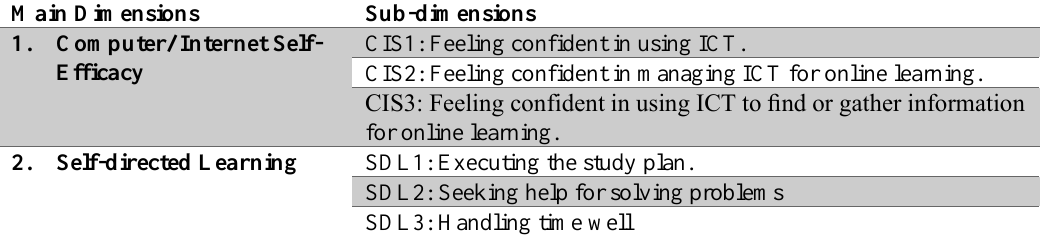
Table 1. Online Learning Readiness Scale